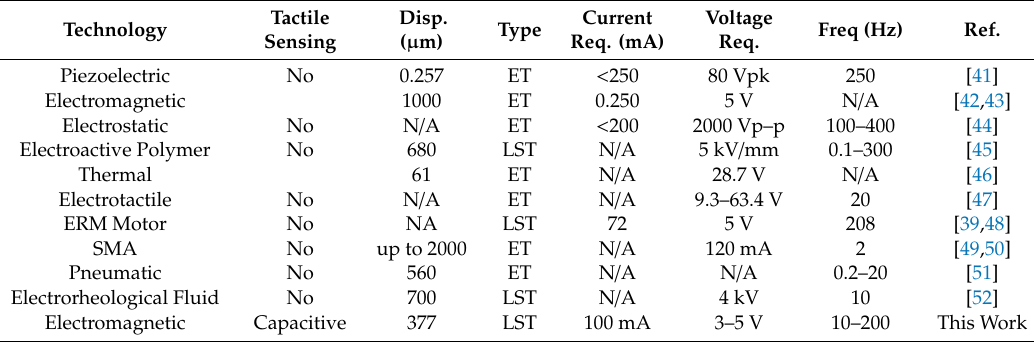
Table 1. Summary of selected tactile displays and their actuation technology.